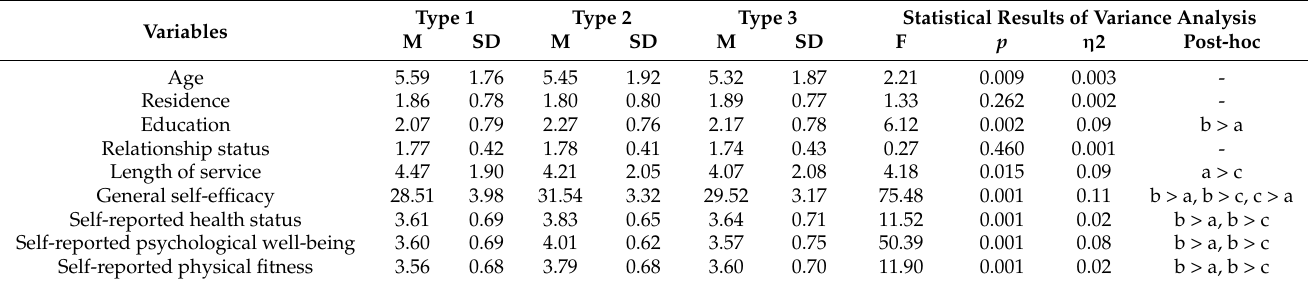
Table 4. Comparative analysis between nurses functioning according to the three types of stress- coping strategies in terms of selected socio-demographic characteristics, condition and